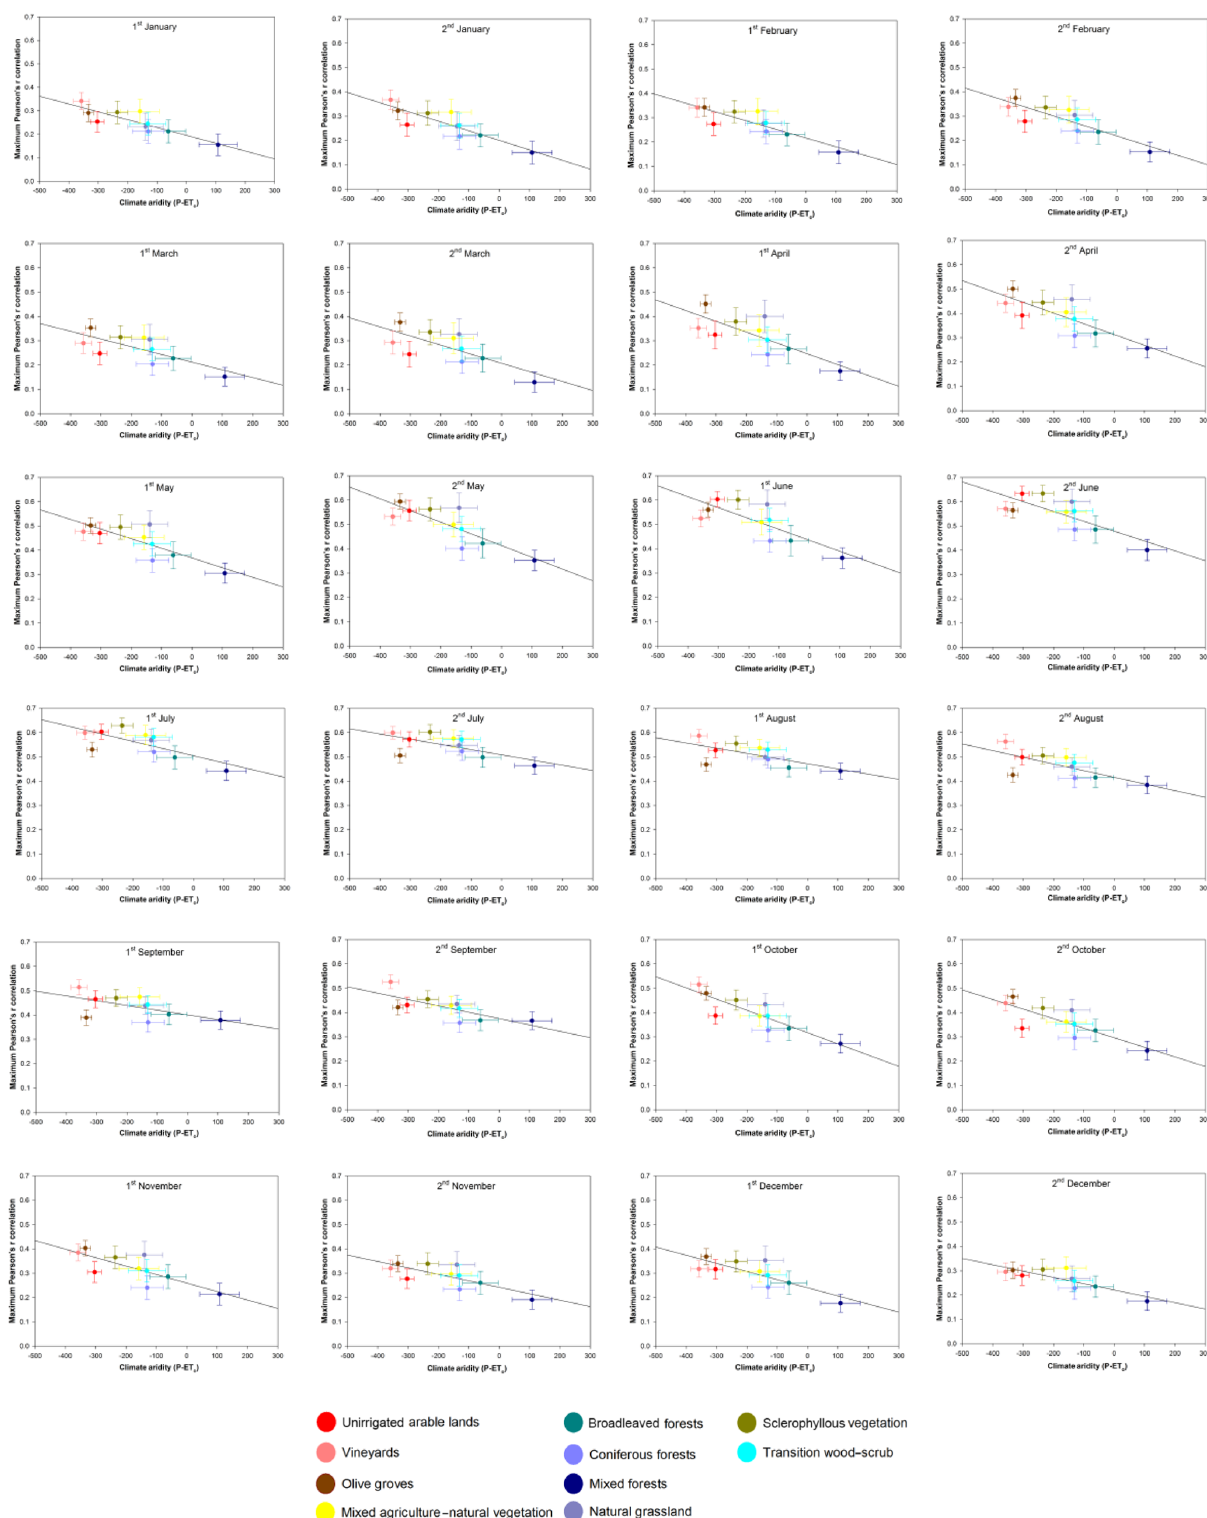
Figure 12. Scatterplots showing the relationship between the mean annual aridity and the maximum correlation found between the sNDVI and the SPEI in the different land cover types analysed in this study. Vertical and horizontal bars represent one-fourth the standard deviation around the mean